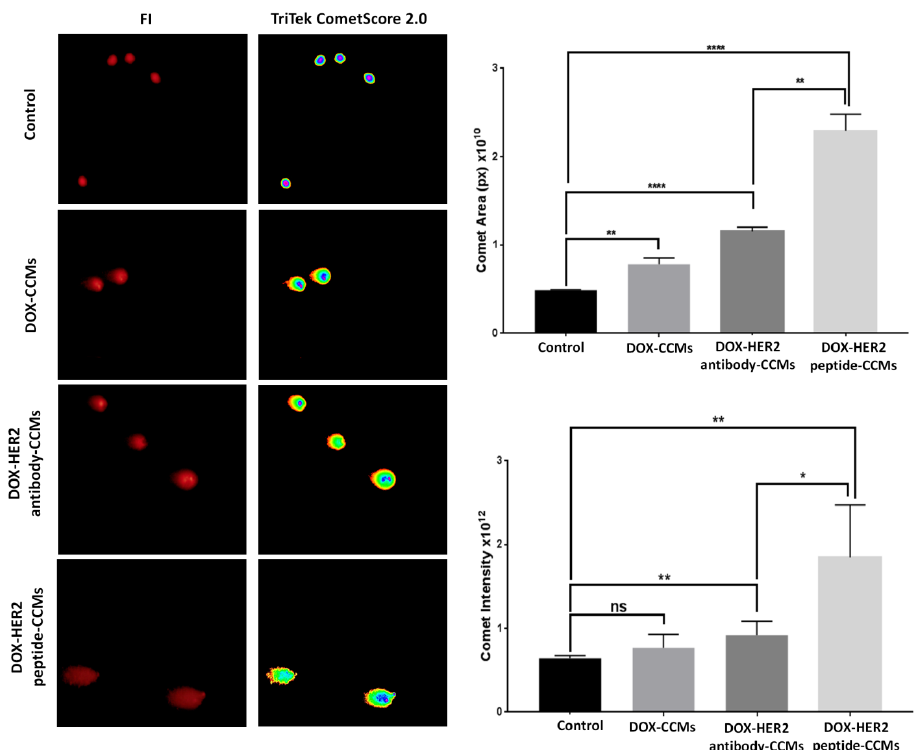
Figure 10. Analysis of the genotoxicity of the IC50-loaded DOX-molecule-loaded, DOX-molecule- loaded HER2 targeting peptide (LTVSPWY) and monoclonal antibody (Herceptin ® ) on SKBR-3 breast cancer cells after 48 h incubation. (FI: Propidium iodide (red) TriTek CometScore 2.0: Fluorescence dye density (multi-to-pink; pink–blue–green–yellow–red)). CometScore is freely available software tool developed bz Rex Hoover (Sumerduck, VA, USA). Note that, these experiments were performed in triplicate and repeated three times under similar conditions, and paired t -test was performed for statistical analysis, and p < 0.05:*, p < 0.01:**, and p < 0.0001:**** were considered significant. Non-significant was shown as